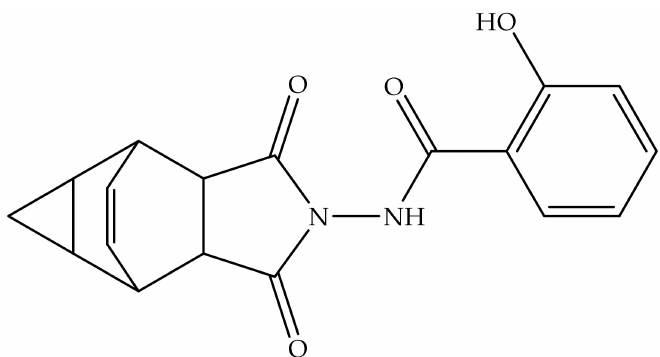
Figure 5. Chemical structure of NIOCH-32. Table 5. In vitro anti-OPV data of NIOCH-14